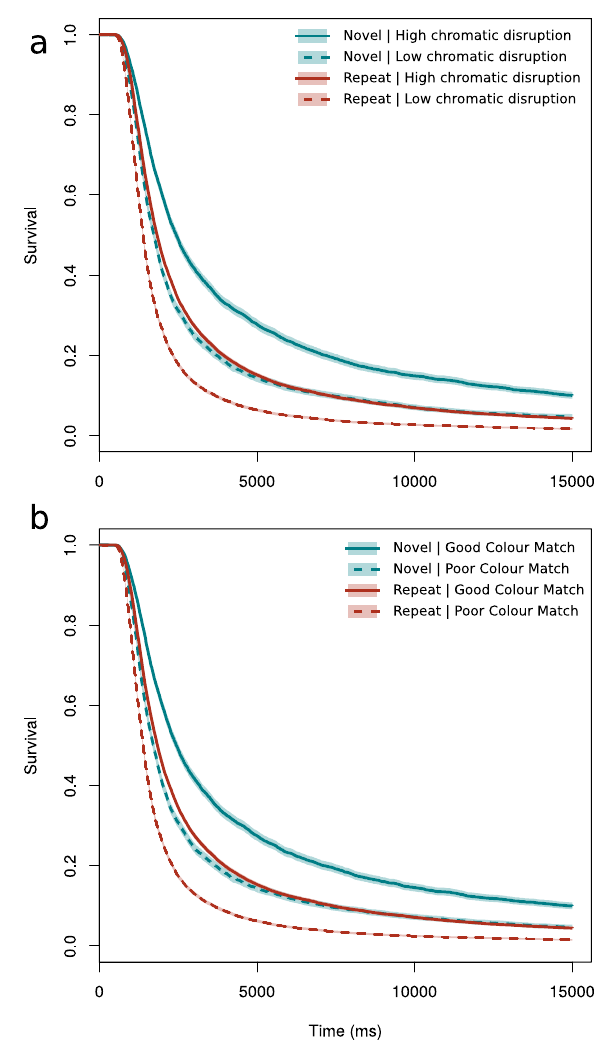
Fig. 3 Survival analysis of novel versus repeat encounters. Survival plots showing the interactions between novel or repeat encounters with the same phenotype, having split the data in to above- or below-median camou fl age (high-low, good-poor respectively, 95% con fi dence intervals shown in the shaded region, based on 40,354 survival events from 1751 participants). a Shows chromatic edge disruption (GabRat in the CIE A channel). b Shows average Euclidean colour distance between the crabs and their backgrounds. These plots show a multiplicative effect where the survival advantage for novel crabs having high chromatic edge disruption, or being a good match to the surroundings is substantially higher than equivalent camou fl age when participants were searching for the same